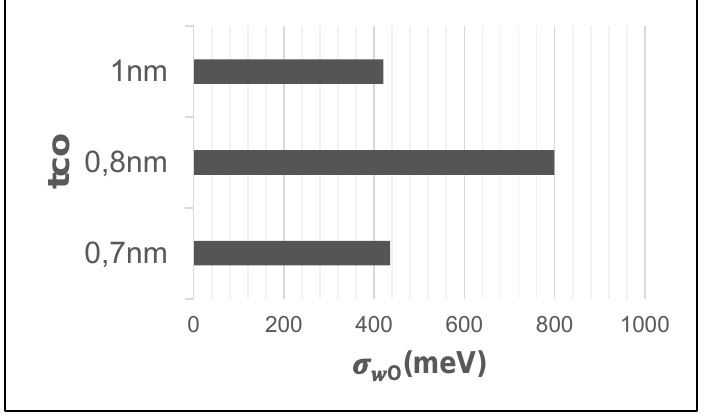
Figure 3. Width of the distributionof the energy barriers in each sample of thickness 𝒕